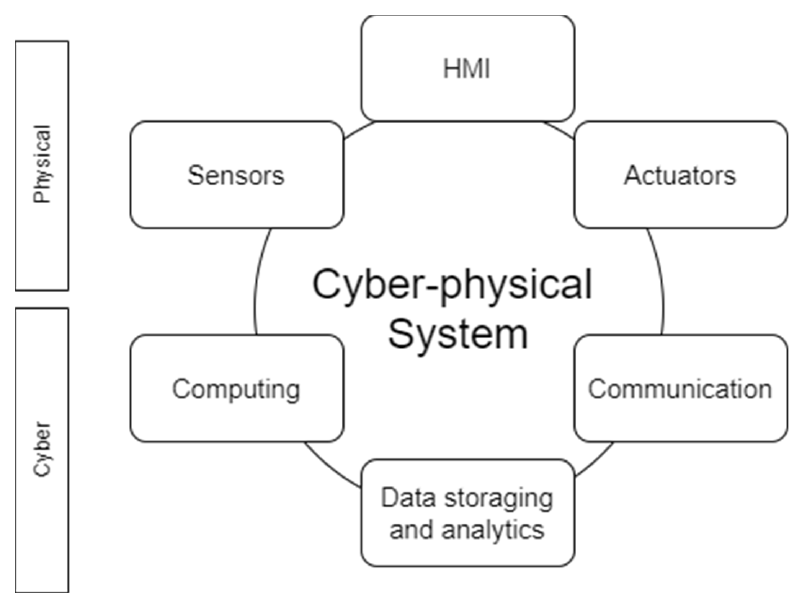
Figure 1. Cyber-Physical system key characteristics.